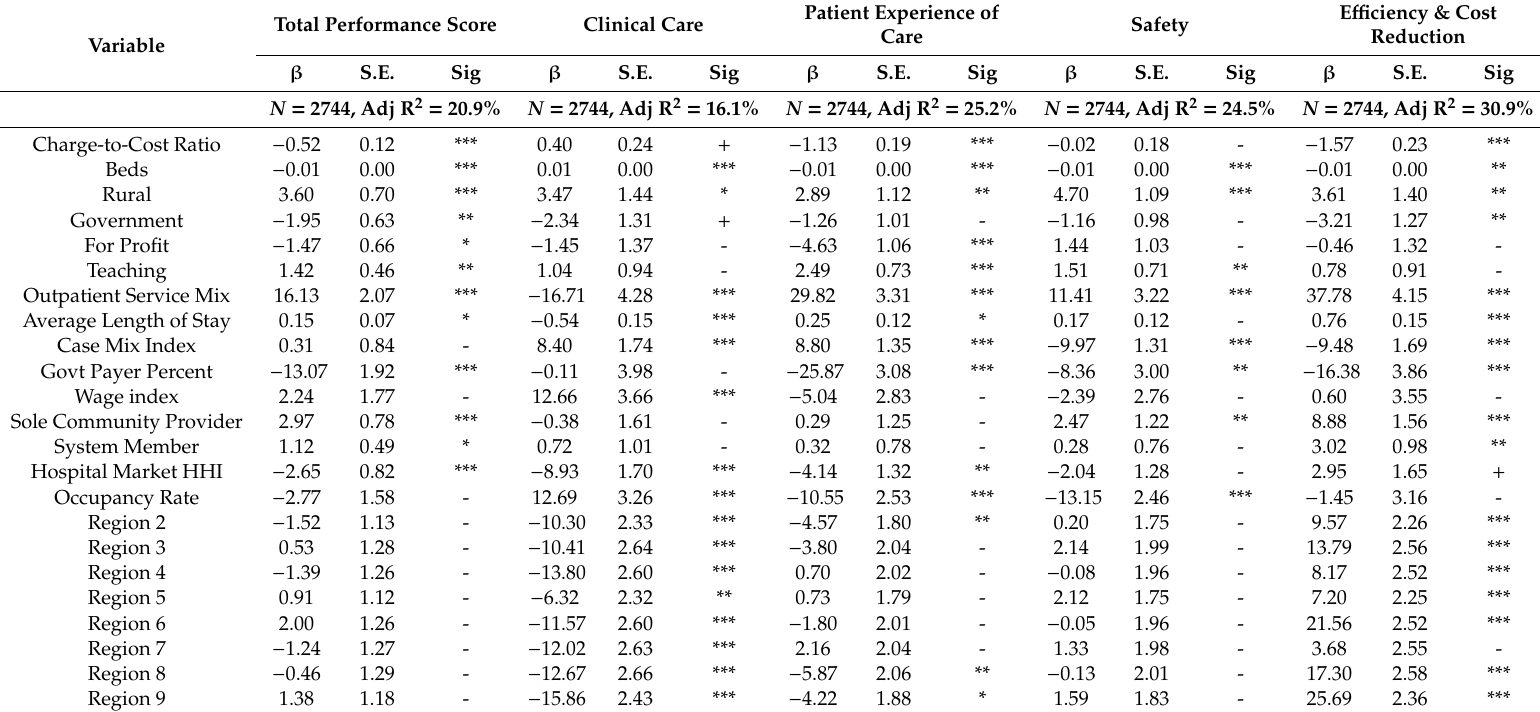
Table 2. Multivariate regression